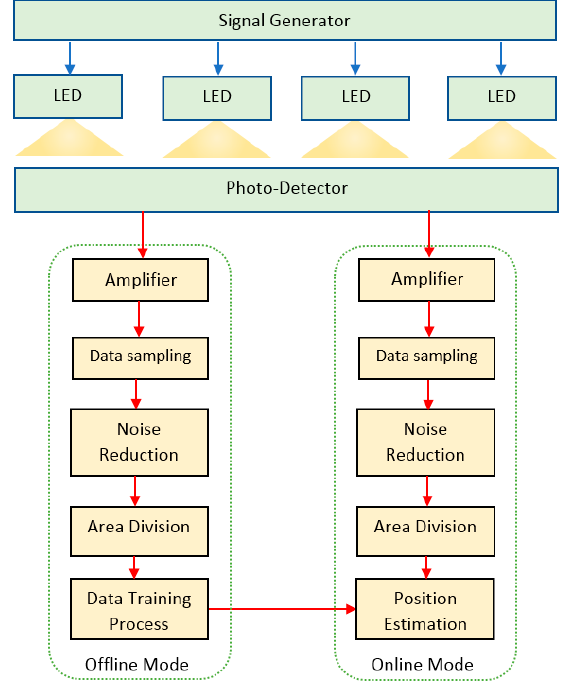
Figure 6. Proposed study method.